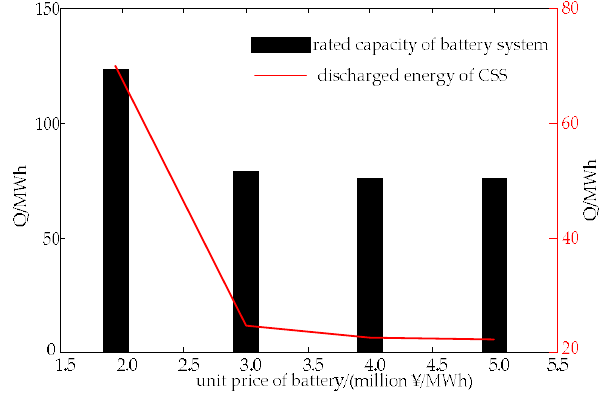
Figure 8. Optimization of battery capacity at different unit prices.